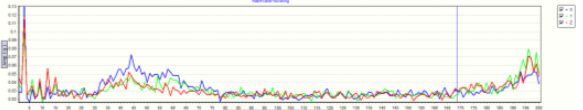
Figure 14 Vibration frequency distribution of Y6 body (12.4kg, in hovering state)